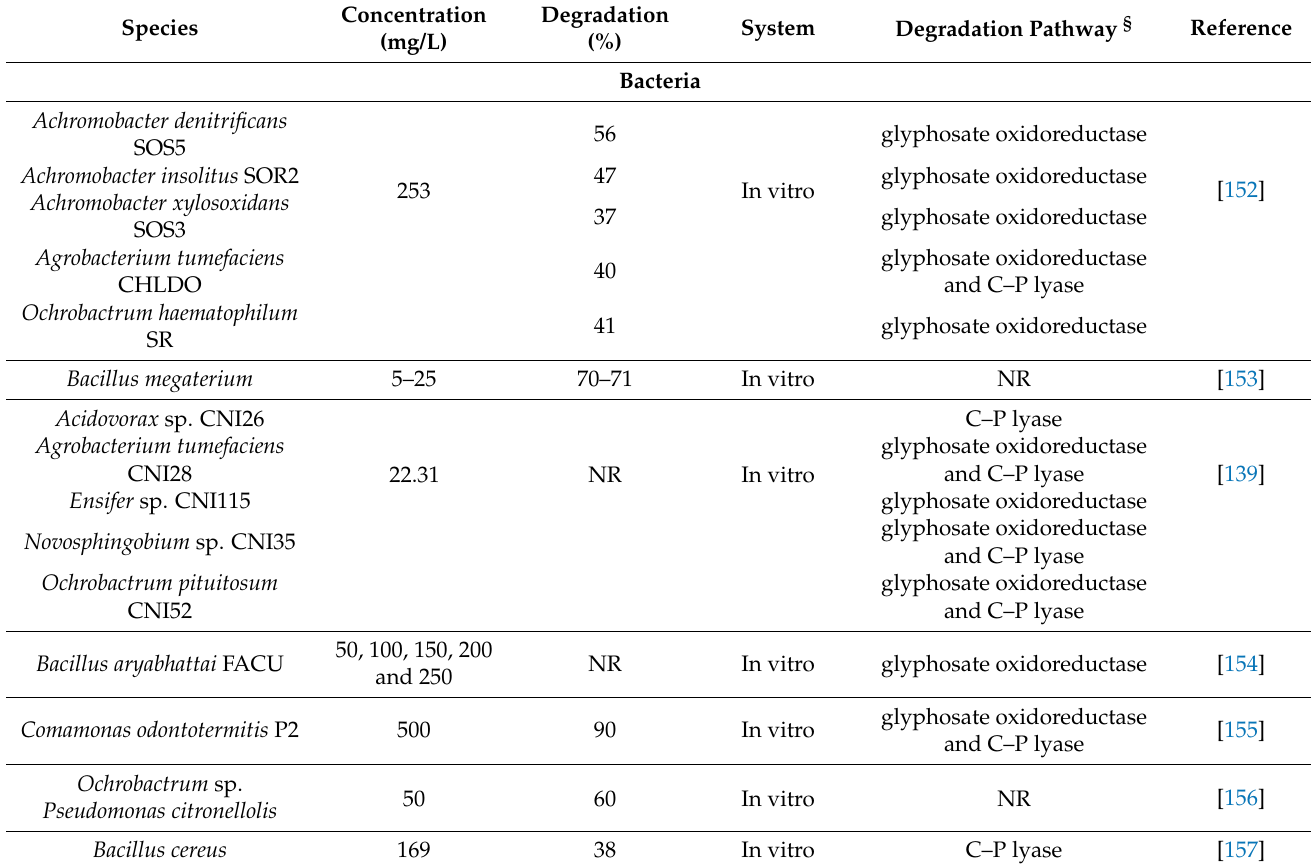
Table 1. Recent reports in microbial glyphosate